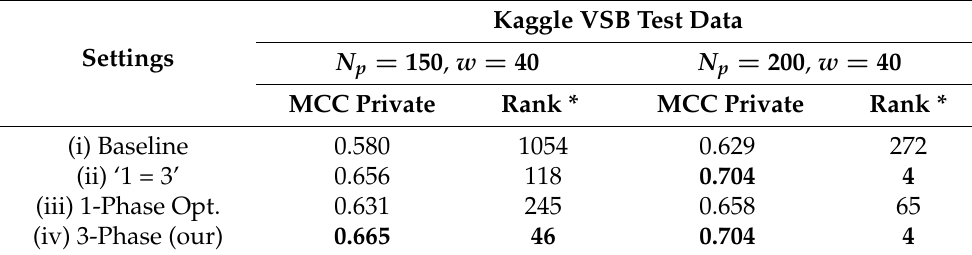
Table 1. Results on the test dataset (evaluated online) for our four proposed decision rules and for N p set to 200 and